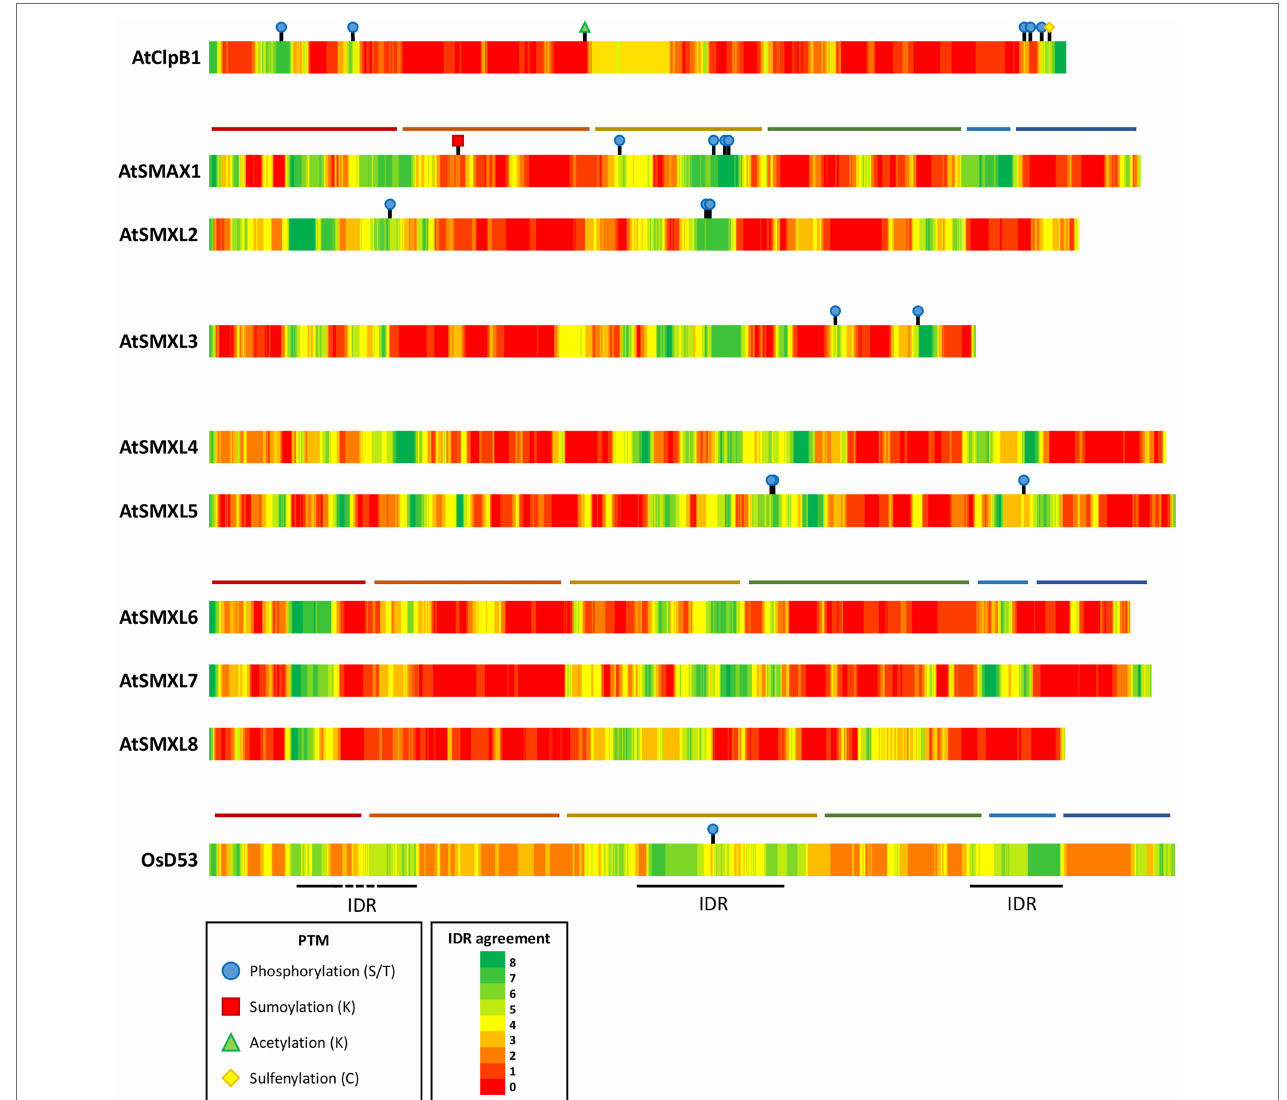
FIGURE 4 | Posttranslational modifications and predicted disordered regions in Arabidopsis SMXLs, ClpB1, and rice D53. Predicted intrinsically disordered regions (IDRs) were acquired from different prediction tools collected by the D 2 P 2 database (Oates et al., 2013). Per amino acid, how many prediction tools agree on the disorder are color indicated. When available, experimentally verified PTMs were obtained from the PTM viewer and displayed on the corresponding locations on the proteins (Willems et al., 2019). The domain structure of AtSMAX1, AtSMXL7 and OsD53 was added represented by horizontal, colored lines: N domain (red), D1 domain (orange), M domain (yellow), D2 domain NTPase 1 (D2a; green), a spacer containing the EAR-motif (light blue), and D2 domain NTPase 2 (D2b; dark